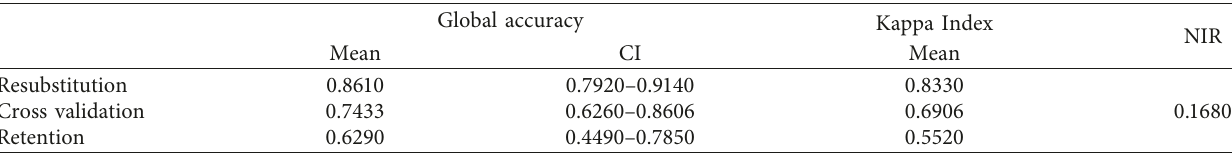
Table 3: Global uncertainty parameters. Confidence interval (CI) and no information ratio (NIR) are reported for global accuracy analysis. Global accuracy